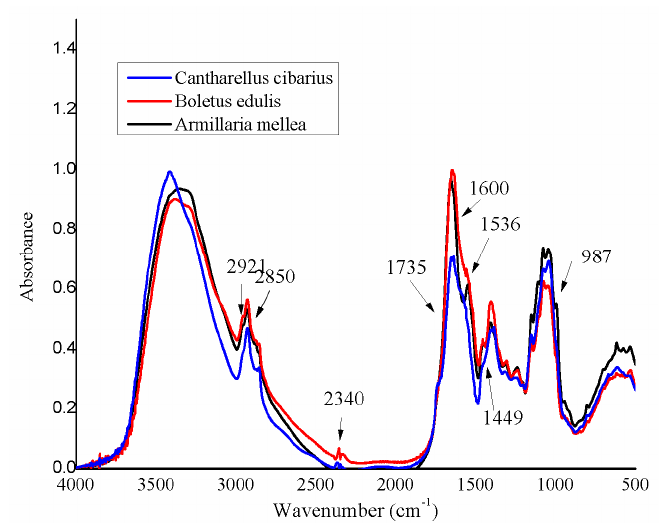
Figure 1. FT-IR spectra of the three selected species.